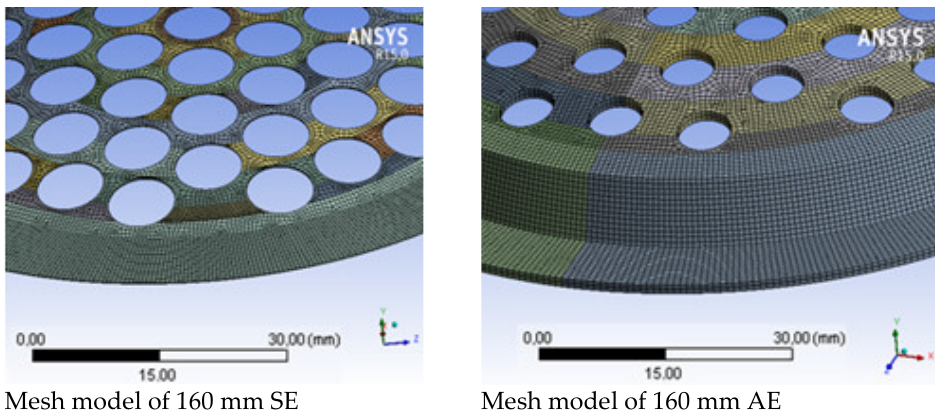
Figure 15. Numerical simulations of electrode geometry in the ANSYS software.